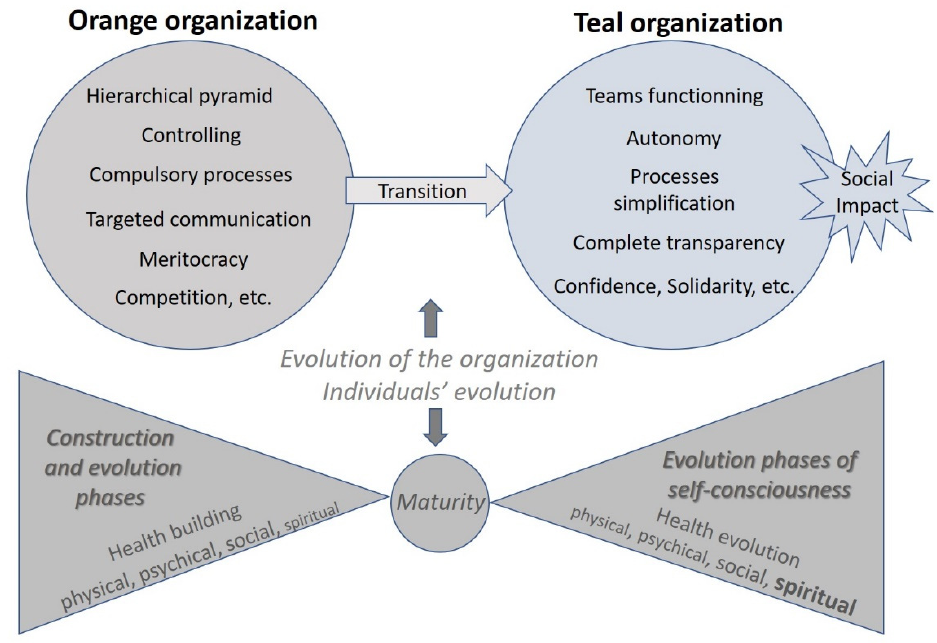
Figure 1. Figure inspired from Laloux and Barrett, illustrating the parallelism between the evolution of organizations and individuals. of organizations and